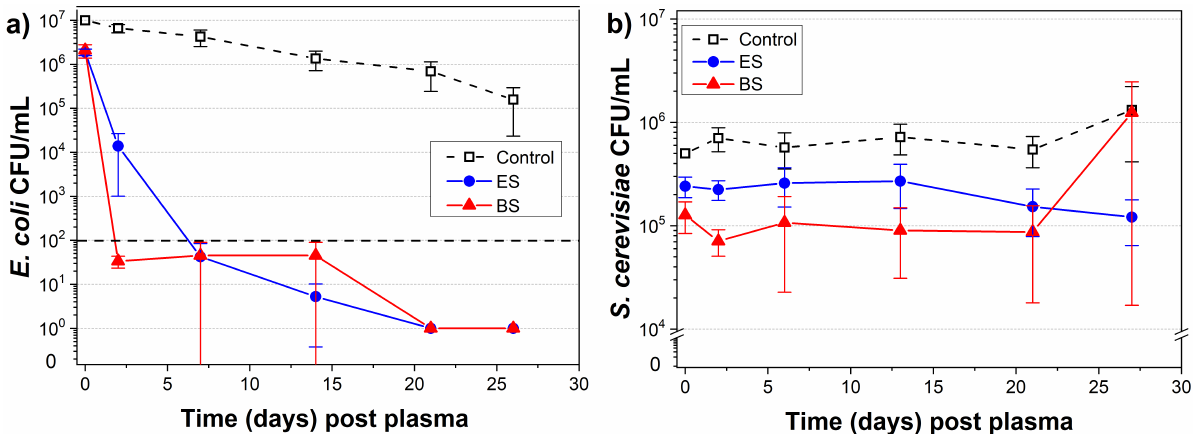
Figure 8. The post-plasma-treatment evolution in the electrospray system (ES) and batch system (BS) of the inactivation rate of ( a ) E. coli bacteria and ( b ) S. cerevisiae yeast with a high initial load in the apple juice, shown as a logarithmic scale (mean ± SD, n = 3). The dashed line in ( a ) represents the acceptable level of E.coli ( ≤ 10 2 CFU/g) in unpasteurized fruit